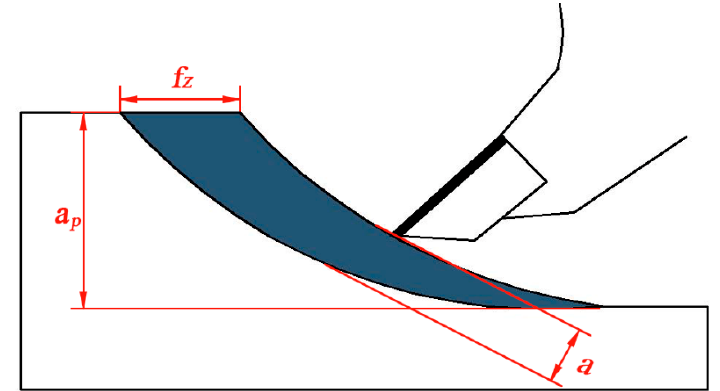
Figure 4. Schematic diagram of feed per tooth, cutting depth and chip thickness in the up milling.